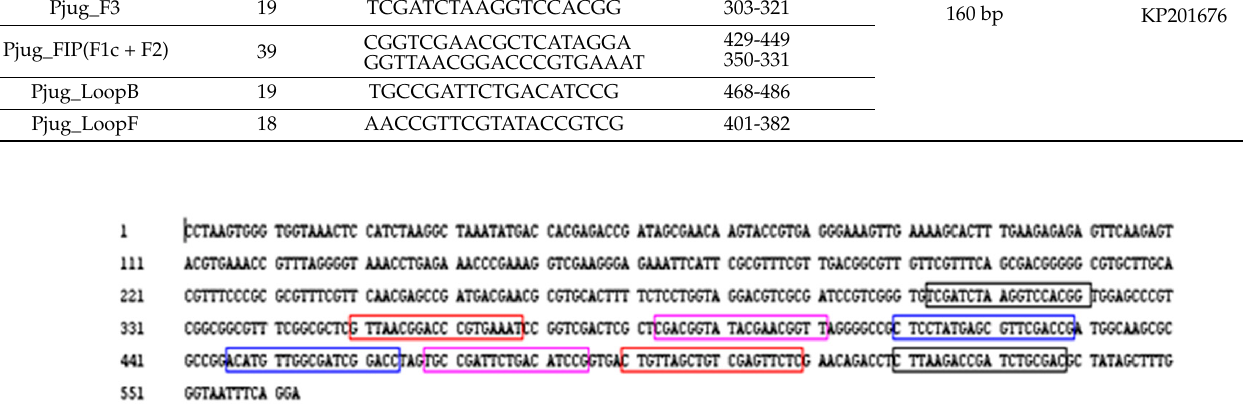
Figure 7. Annealing sites of the LAMP primers on the 28S ribosomal RNA gene sequence of P. juglandis (accession number, KP201676.1): F3/B3 (black), LoopB/LoopF (purple), B2/F2 (red), F1c/B1c (blue).